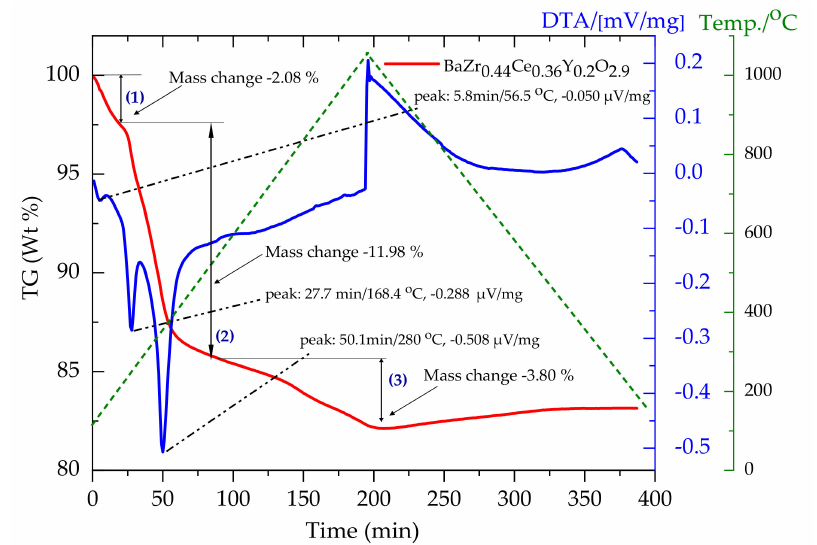
Figure 3. Thermogravimetric analysis (red curve) / di ff erential thermal analysis (DTA blue curve) curve of BZCY(54) 8 / 9 2 electrolyte as measured in the coupled TG / DTA–MS